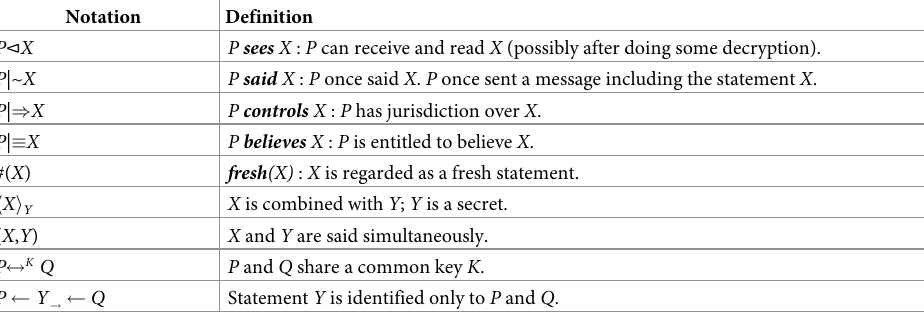
Table 2. Notations of BAN